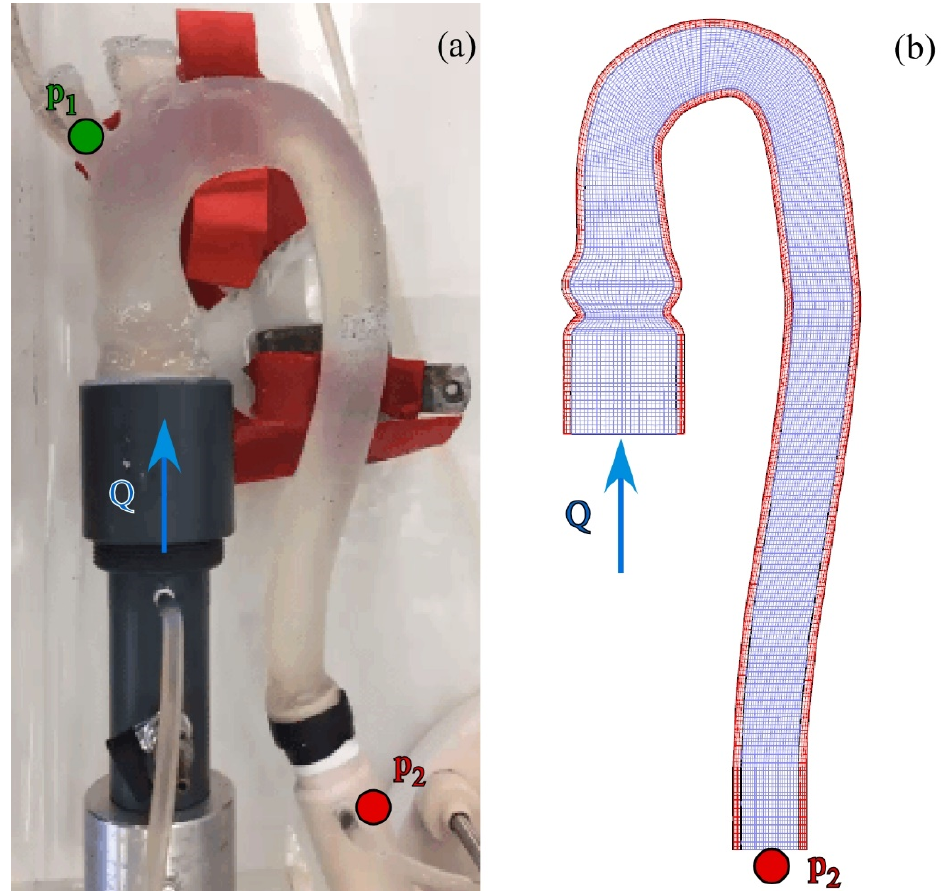
Figure 4. Aorta’s replica of the study. ( a ) Real silicone phantom placed in the Pulse Duplicator, and ( b ) corresponding in-silico models of the aorta (in red and blue the solid and fluid mesh, respectively). The boundary conditions are reported in both panels, i.e., flow rate Q (uniform velocity) at the inlet and time-varying pressure recorded by the probe p 2 at the outlet. p 1 reported in ( a ) shows the additional probe placed at the brachiocephalic